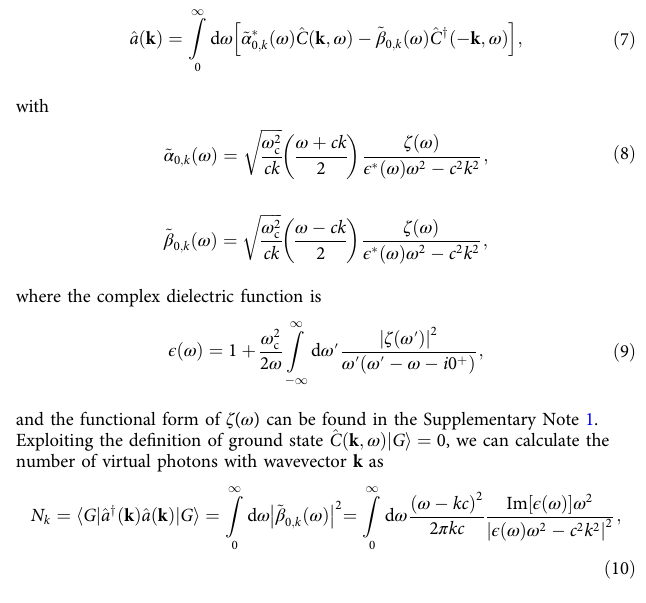
per mode, showing that it is also a monotonously decreasing function of the photonic wavevector k , saturating at E max ¼ (cid:1) h ω 2 ffiffiffiffiffiffiffiffiffiffi p for very red-detuned photons. c ω 2 þ ω 2 4 c 0